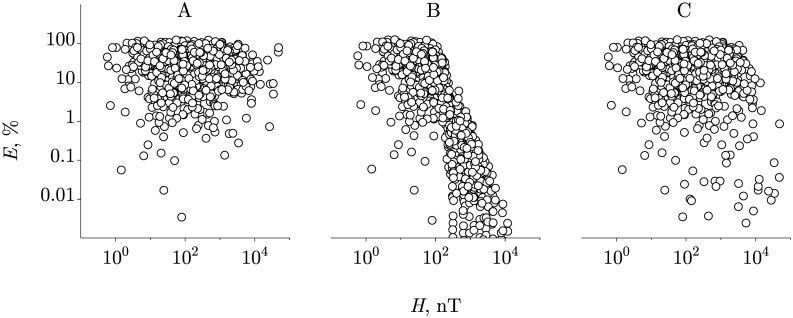
A numerical simulation of HMF effects.Effects that are expected in 1000 different biological species under the following model assumptions: A—unconditional HMF effects at f ≡ 1, B—HMF effects at f = f(H, Hth) with a fixed Hth = 100 nT, C—HMF effects at f = f(H, Hth) with a widely distributed Hth.